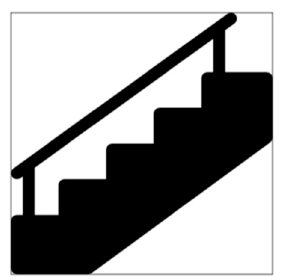
Figure 10. Pictogram-based “Stairs”. Figure 11. Axonometric-based “Stairs”.